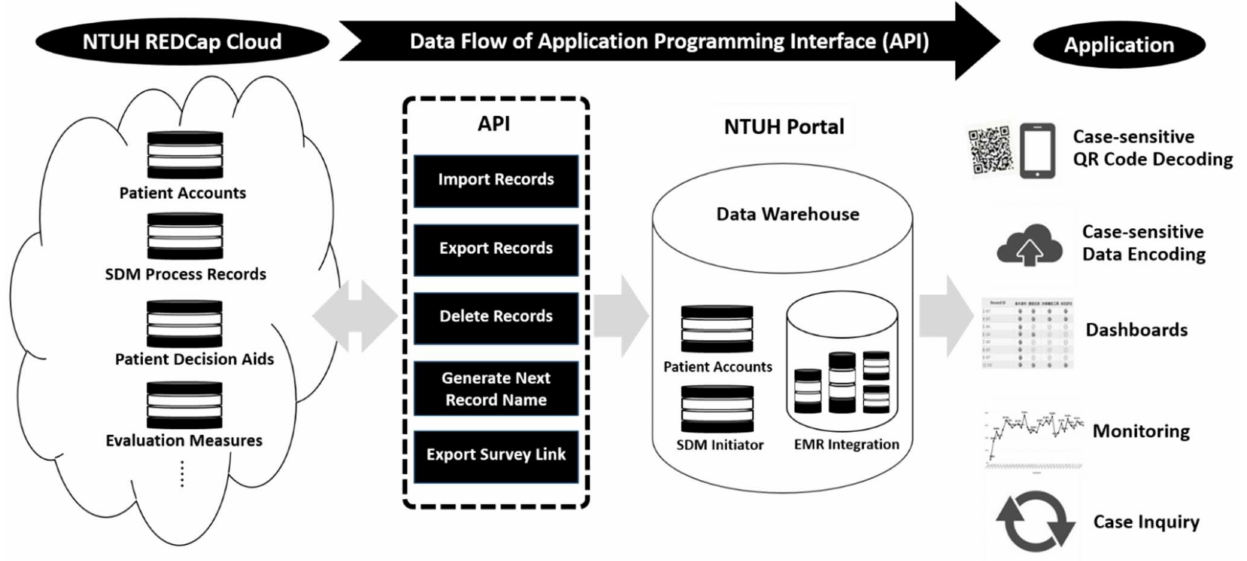
Figure 1. Schematic process of Research Electronic Data Capturing (REDCap) application in shared decision-making (SDM)